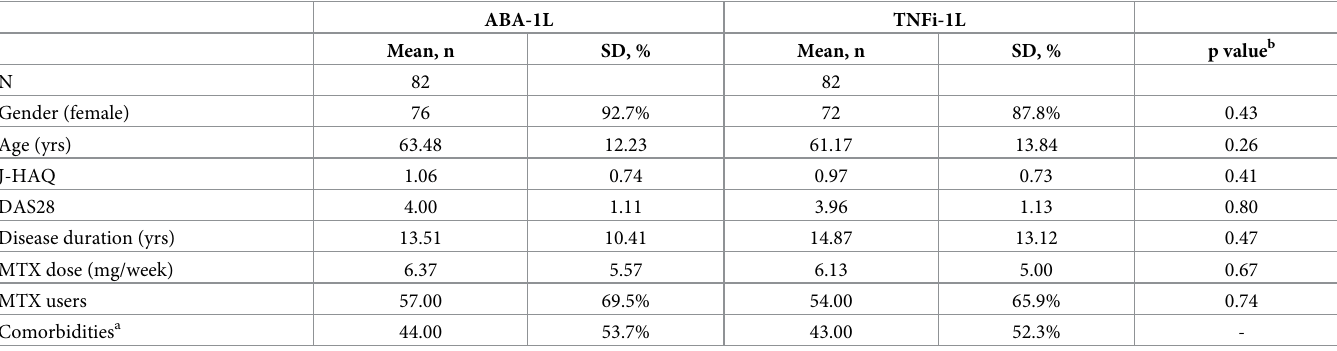
Table 1. ABA-1L vs. TNFi-1L: Patient characteristics of matched populations.